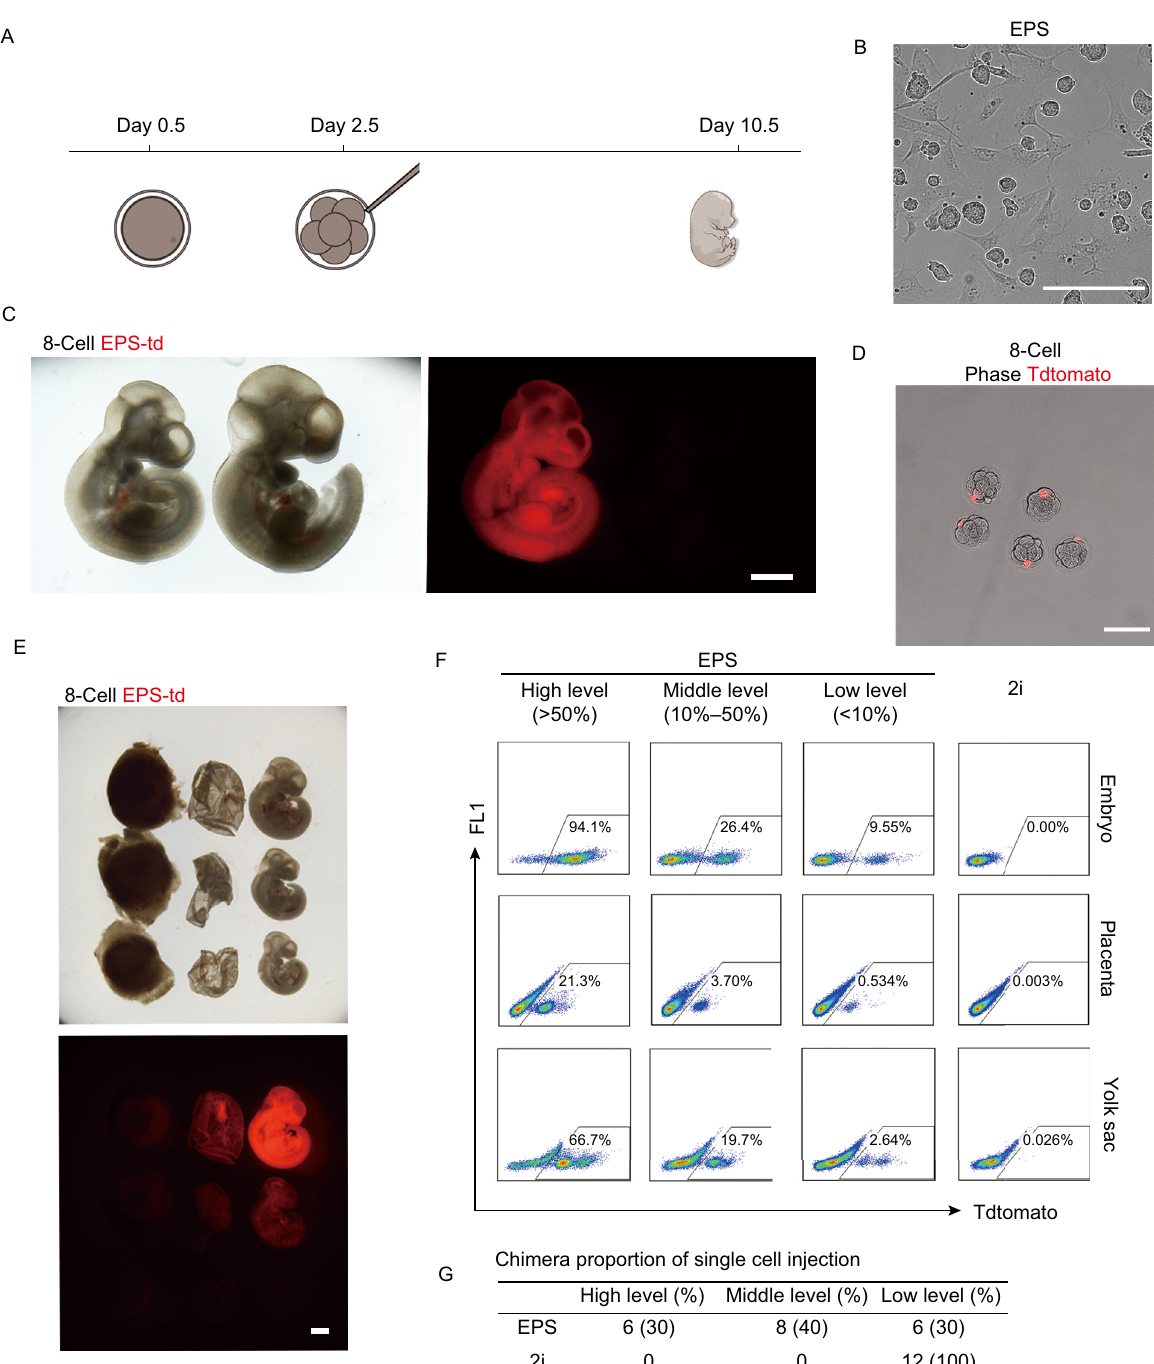
Figure 1. EPS cells have superior ef fi ciency in generating chimeras. (A) Strategy of injecting mouse EPS cell into 8-cell